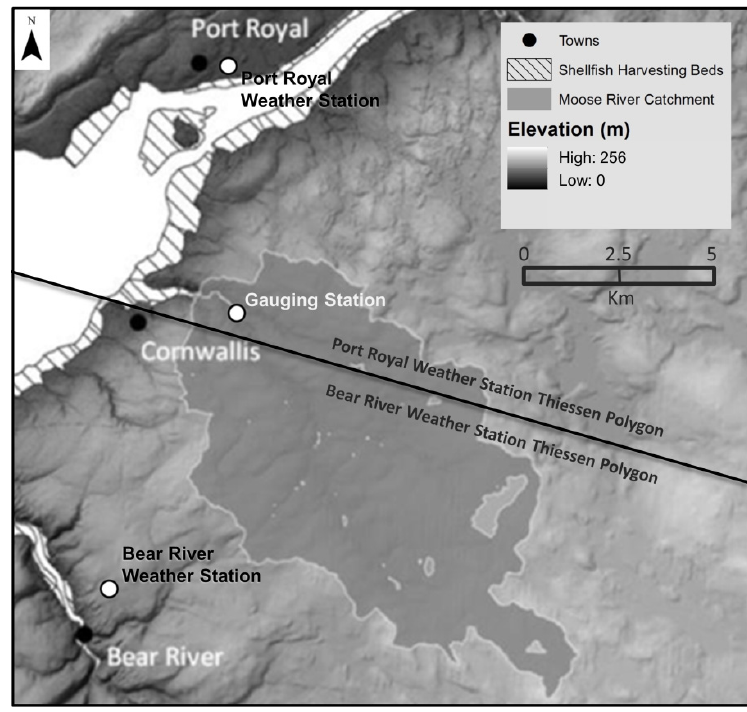
Figure 2. Moose River catchment with Thiessen polygons. Bear River weather station meteorological data was used for input into the MIKE 11